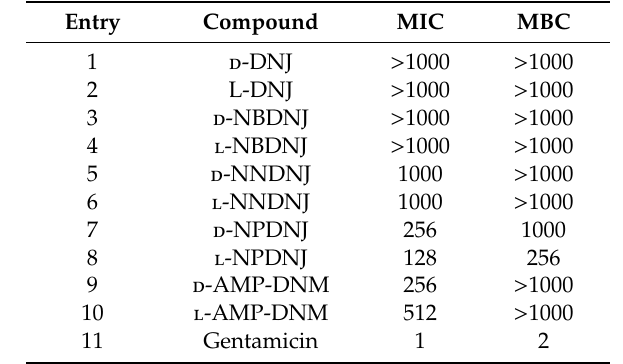
Table 1. Minimum inhibitory concentration (MIC) ( µ g / mL) and minimum bactericidal concentration (MBC) ( µ g / mL) values of d - and l -DNJ and their N -alkyl derivatives against S. aureus ATCC 29213.